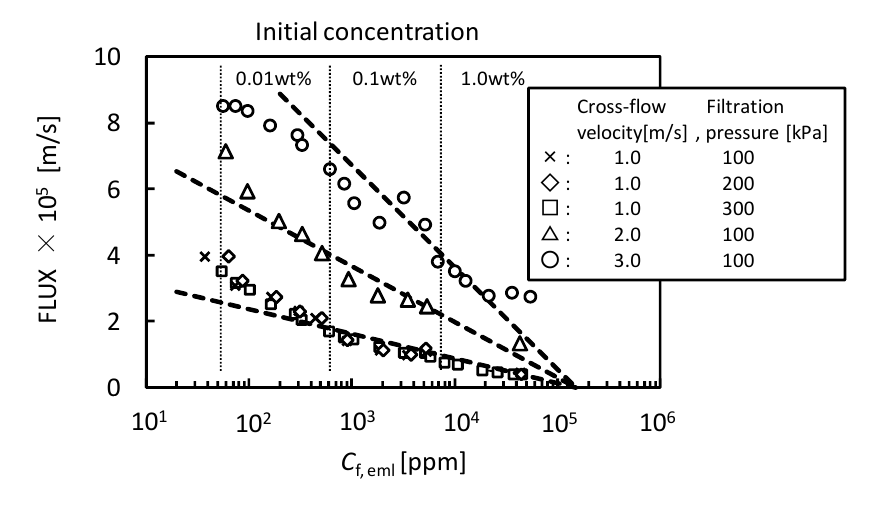
Figure 9. Concentration properties of O/W emulsion in batch cross-flow concentration filtration with UF membrane (nominal pore size 5